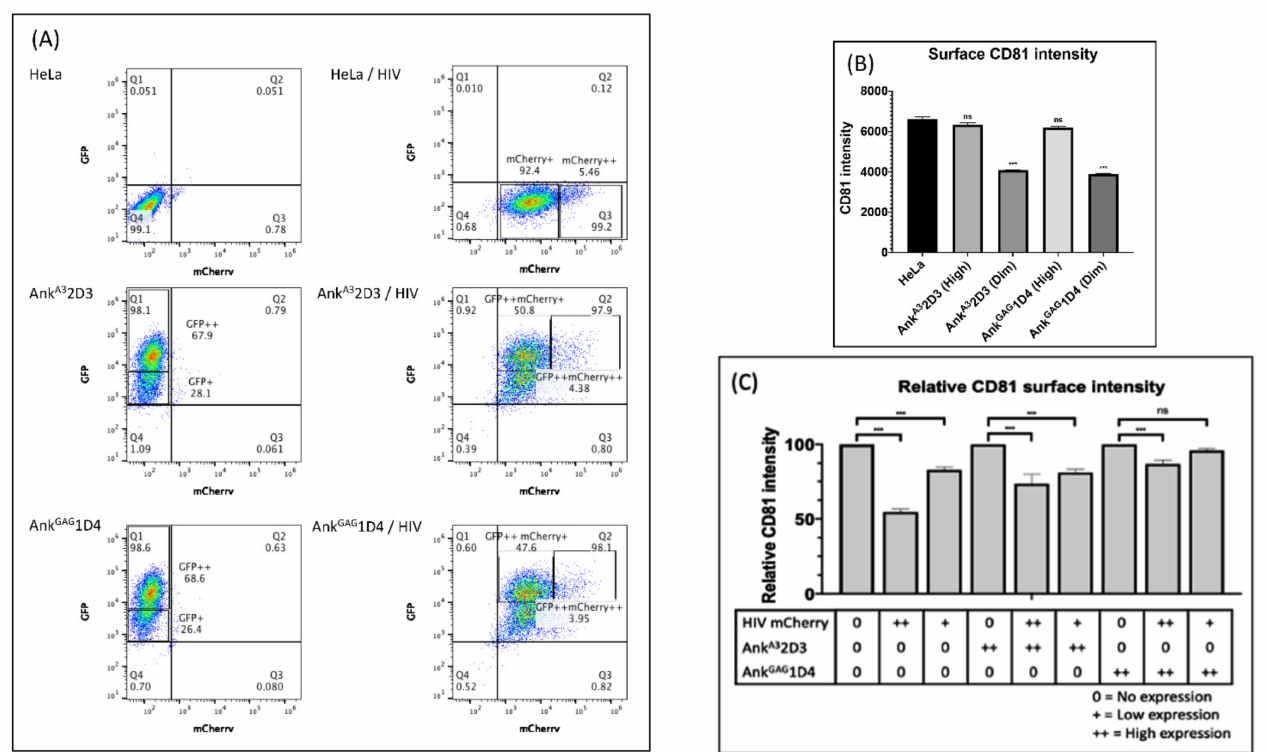
Figure 6. CD81 tetraspanin surface intensity and viral production. HeLa cells and HeLa cells stably expressing Myr (+) Ank GAG 1D4-GFP or Myr (+) Ank A3 2D3-GFP were transduced with VSV- G-pseudotyped HIV-1 GagmCherry. ( A ) After 48 h, the level of ankyrin expression and HIV-1 GagmCherry expression was analysed by flow cytometry. Populations were defined based on their fluorescence intensity ((+) = intermediate expression, (++) = high expression). ( B ) Surface CD81 expression on non-transduced cells was measured by flow cytometry. The intensity of CD81 on non-transduced HeLa and ankyrin-expressing HeLa cells was shown in Bar graph. ( C ) Surface CD81 expression on transduced HeLa and ankyrin-expressing HeLa cells was determined by flow cytometry. Relative surface CD81 intensity was calculated by the percentage of surface CD81 intensity of transduced cells and normalised against surface CD81 intensity of non-transduced cells. Data represent the mean ± SD from triplicate independent assay. Significant differences (*** p < 0.001;